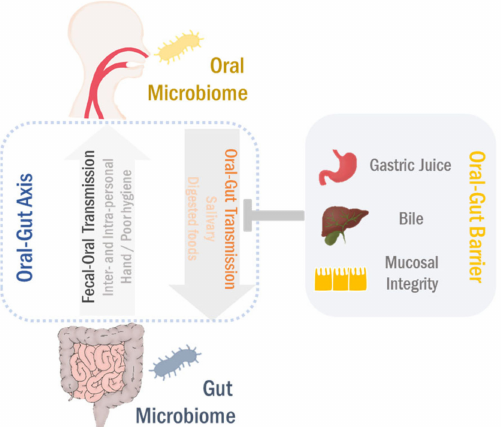
Figure 2. Oral–gut microbiome axis. The oral microbiota can translocate to the gut in conditions of the oral–gut barrier disruption. Likewise, the gut microbes transmit to the oral cavity in both intra- and interpersonal manners, particularly related to poor hygienic conditions. This bidirectional interaction between oral and gut microbiomes develops the microbial ecosystems in both habitats through either competition or cooperation, eventually regulating the pathophysiological processes in the gastrointestinal (GI)